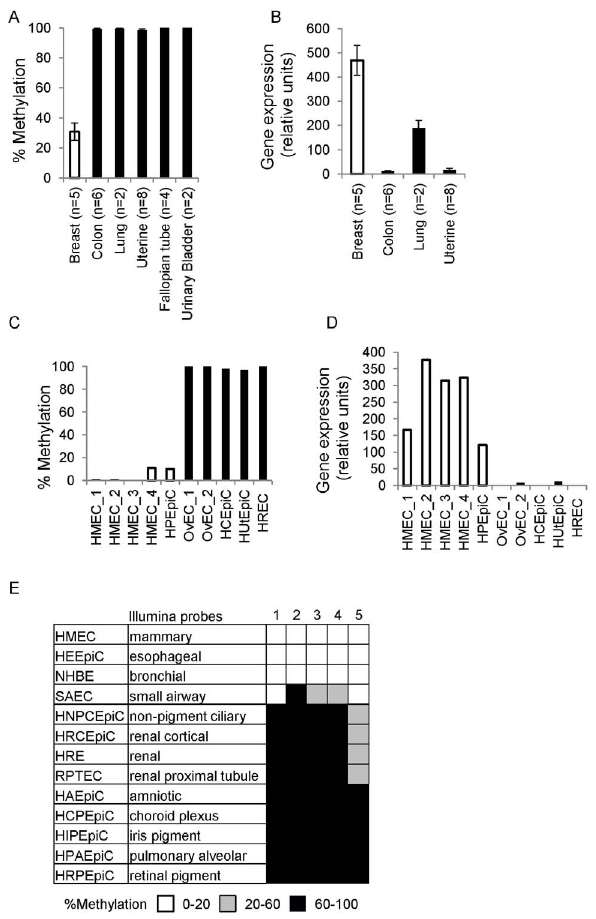
Figure 3. TRIM29 promoter methylation and gene expression varies in normal epithelial tissues. ( A&C ) Q-MSP at TRIM29 promoter in ( A ) various human normal tissues enriched for epithelium and ( C ) purified human normal epithelial cells. The same tissue samples studied by the Illumina methylation array were included in (A). Q-MSP amplicon overlapped with the sequence of Illumina probe # cg13625403 used for array analysis ( Table S4 ). ( B&D ) The same samples were used for gene expression analysis by qRT-PCR that showed inverse correlation with promoter methylation (RNA was not available for fallopian tube and urinary bladder). HMEC- human mammary epithelial cells, HPEpiC-prostate, OvEC-ovarian, HCEpiC- colon, HUtEpiC-uterine, HREC-renal. ( E ) Data from Illumina Infinium methylation450K array obtained from ENCODE showed similar pattern of TRIM29 promoter methylation in additional purified human normal epithelial cells. Methylation at 5 Illumina probes is shown: 1.cg20655548 2.cg12201660 3.cg17971587 4.cg13285004 5.cg13625403 ( Table S4B ). Each row refers to one individual.